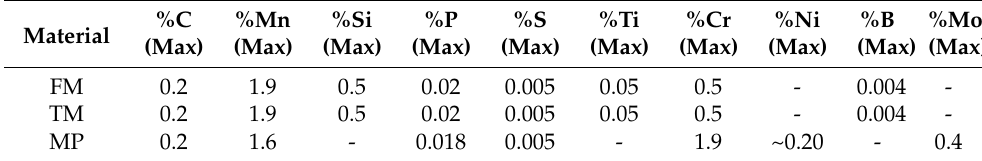
Table 1. Chemical composition of the tested materials [wt%].